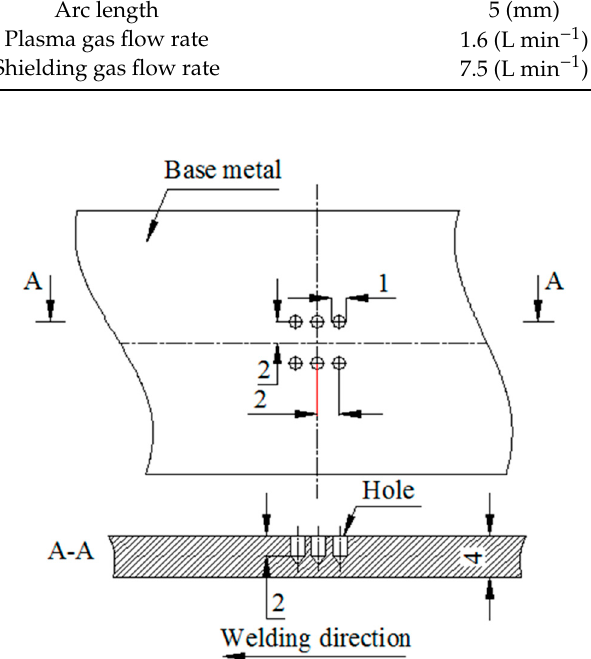
Figure 2. Schematic illustration of holes on the base metal surface.